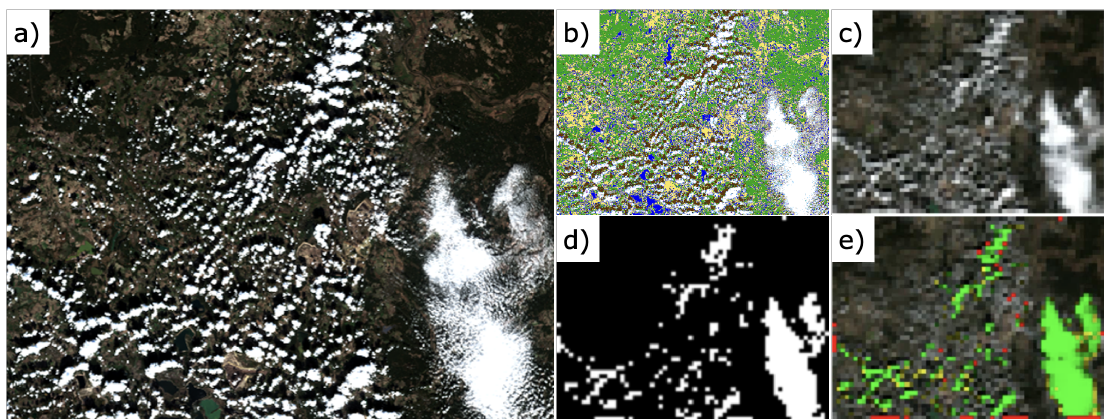
Figure 18. The effect of input image resize. Thin or small features are blended into neighboring pixels, resulting in underestimating cloud coverage in scenes with high populations of thin or small